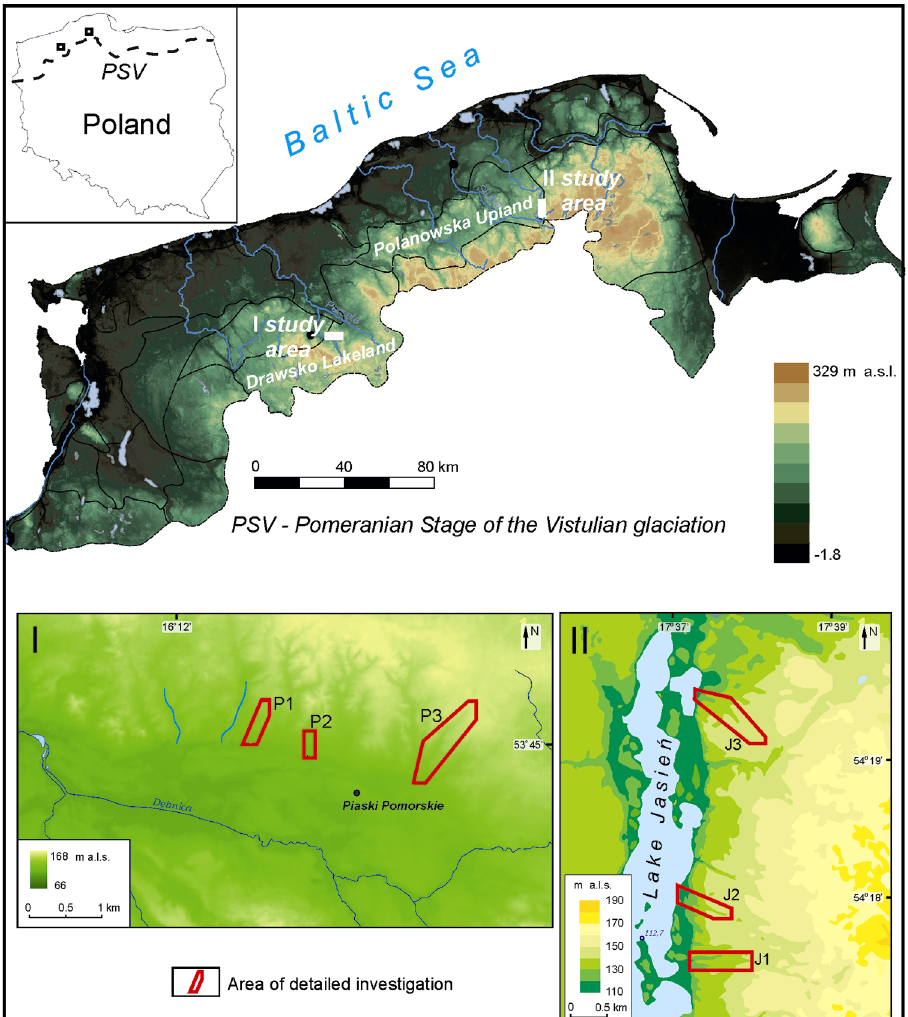
Fig. 1. Location of the survey area: I – Piaski Pomorskie test area; II – Jasie ń test